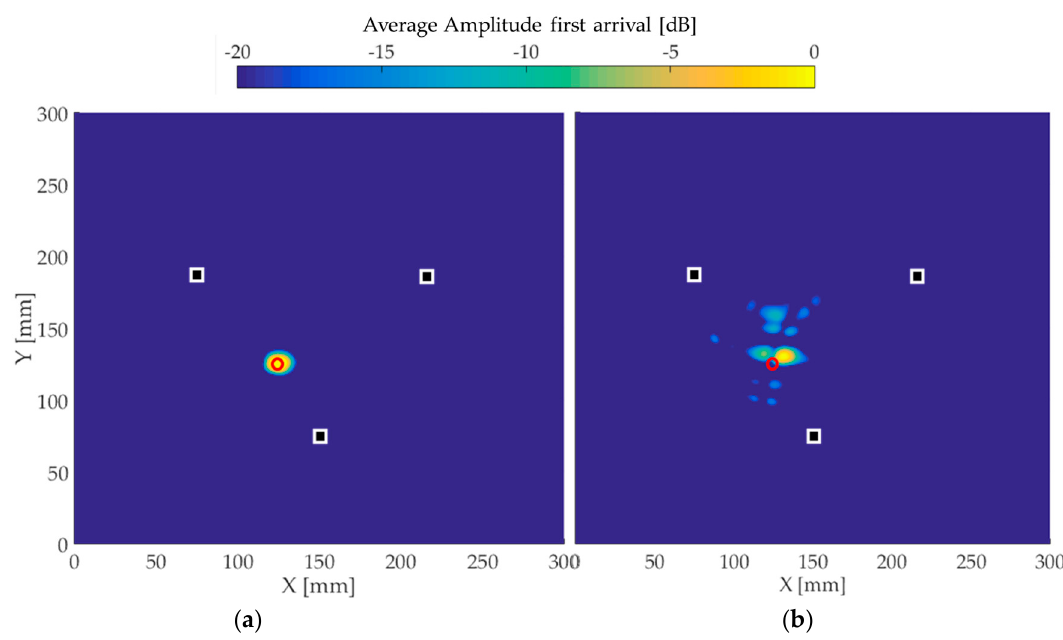
Figure 9. Reconstructed images for the first 5 mm through-thickness hole. The white squares represent the transducers positions and the red circles correspond to the defect position. ( a ) The image using simulated time traces and ( b ) the experimental image.